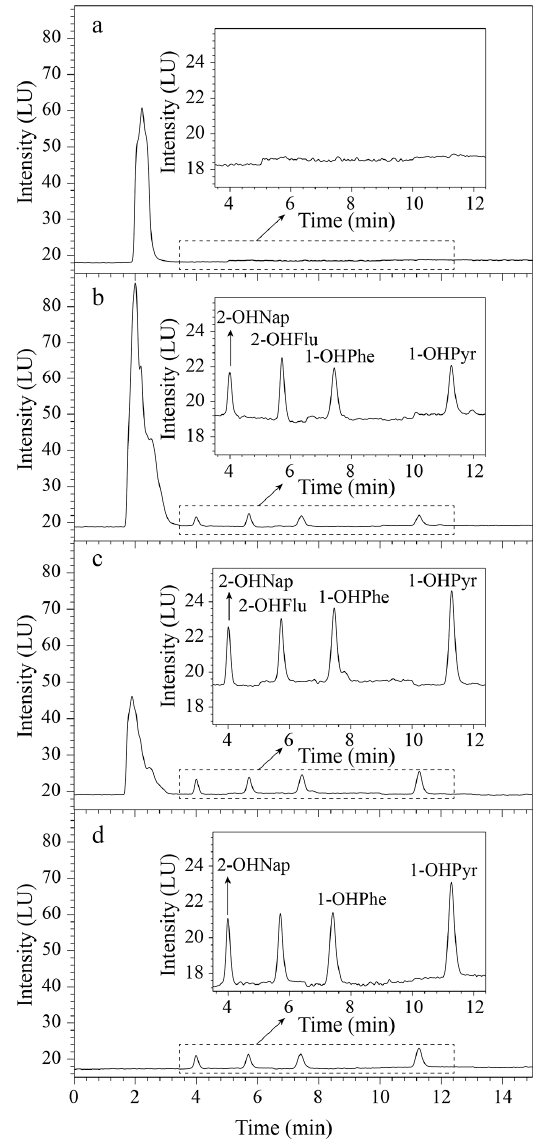
Figure 3. Chromatograms of urine samples (spiked with 2 ng / mL of 2-OHNap and 1-OHPyr, 1 ng / mL of 2-OHFlu and 2-OHPhe) with ( a ) direct injection, ( b ) solid-phase extraction (SPE) by commercial C 18 adsorbent, ( c ) SPE of the GO@Dt–NH 2 composites, and ( d ) the standard solution of OH-PAHs.